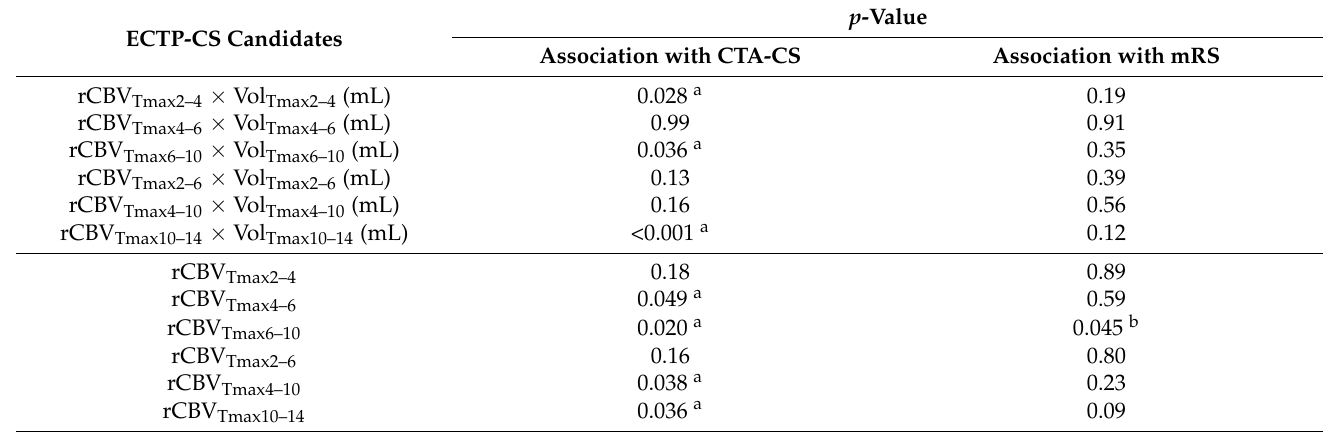
Table 2. Results of Jonckheere-Terpstra tests of the associations of the baseline CTP-based collateral score (CTP-CS) candidates with baseline single-phase CTA-based collateral score (CTA-CS) and ordinal 90-day mRS.